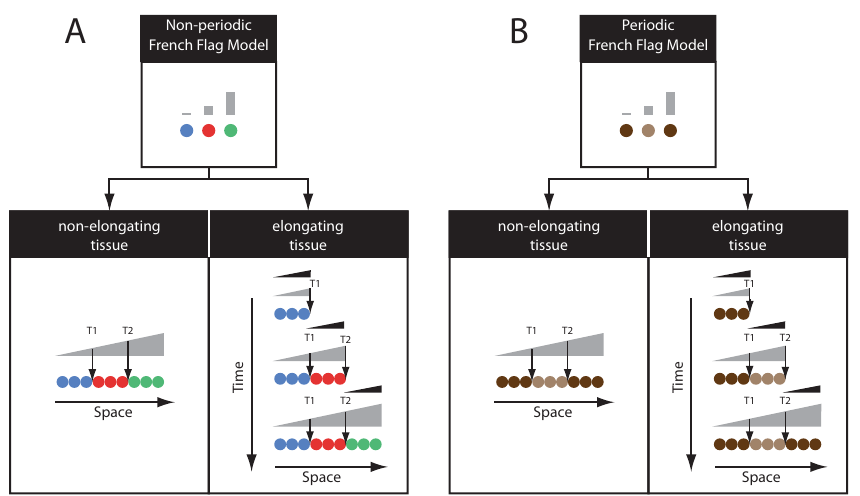
Fig 3. The FF model (see also Box 1). (A) Top panel: In the FF model, different concentrations of a morphogen gradient (shown in gray) activate different cellular states (shown in different colors). The FF model can pattern nonelongating tissues (bottom left) via a nonregressing gradient (shown in gray), as well as elongating tissues (bottom right) if a retracting short-range gradient (shown in black) activate a slowly decaying morphogen (gray). (B) In a similar fashion, the FF model can generate periodic patterns if a complex regulatory logic of periodically expressed genes (shown in brown) is employed or if an intermediate step of nonperiodic patterning is introduced. FF, French